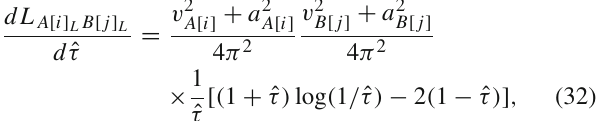
Fig. 6 Quasi-luminositiesfortheDYandVBFLHCprocessesat 13 TeV as functions of the CMS energy of the colliding